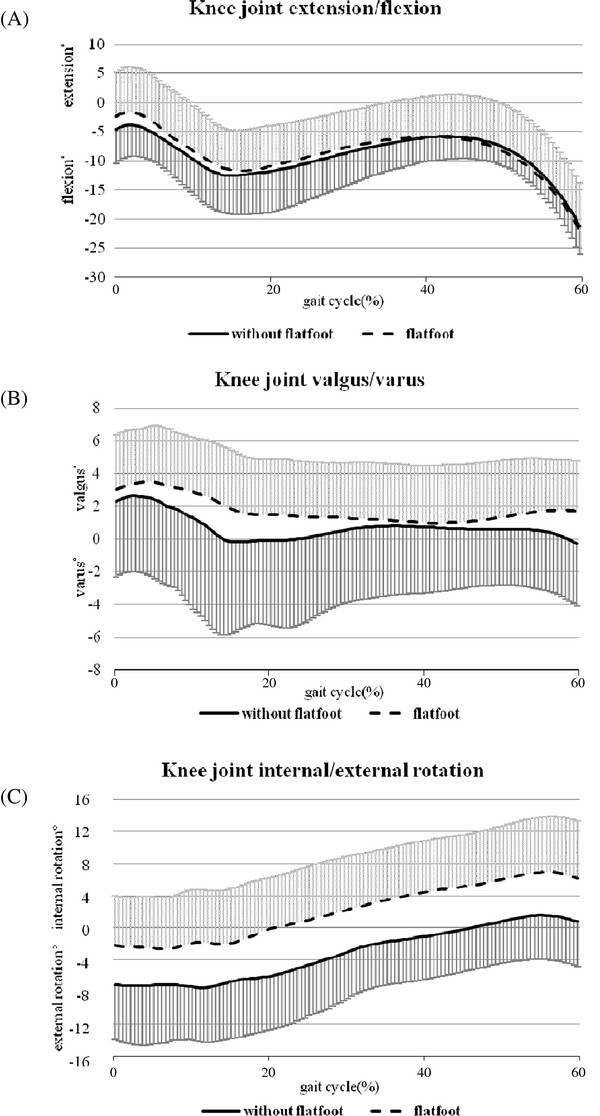
Movement pattern of the knee joint. (A) Extension/flexion, (B) valgus/varus, and (C) internal/external rotation in children with (n = 20) and without (n = 10) flexible flatfoot during the stance phase (0-60% of the gait cycle) of comfortable walking. The standard deviations are shown in one direction.